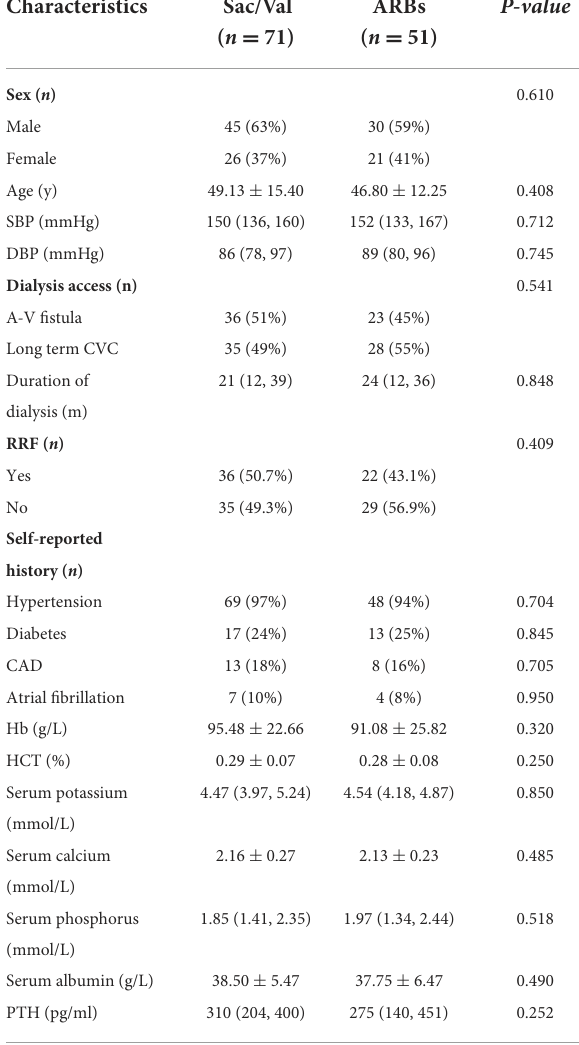
TABLE 1 Clinical characteristics of patients at